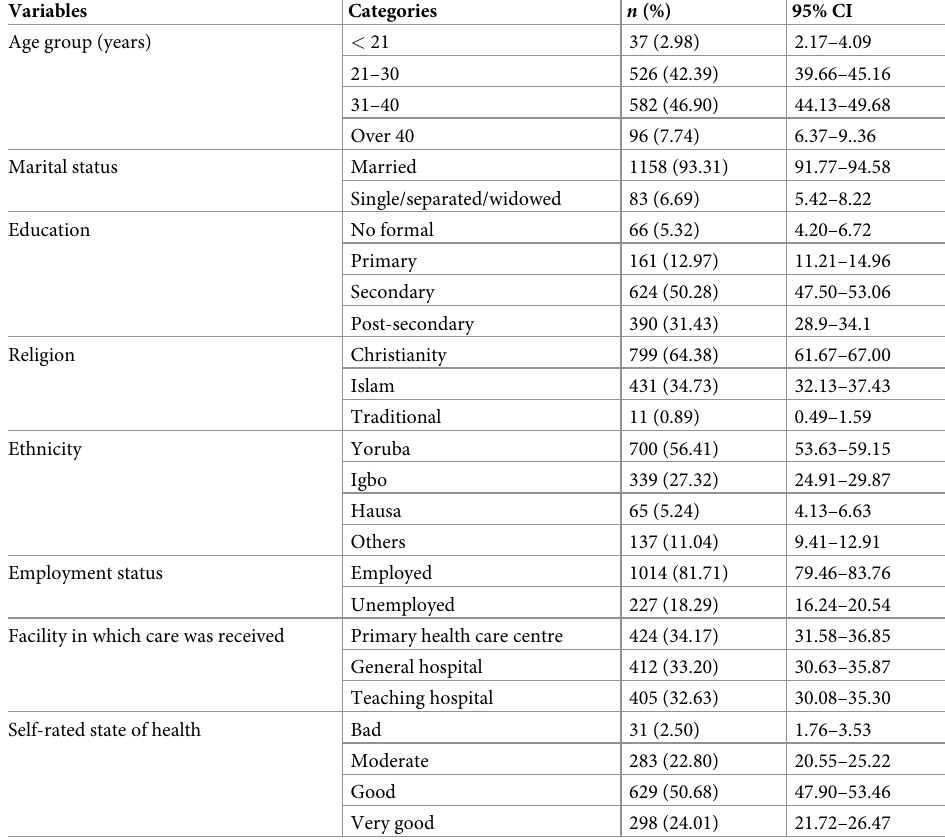
Table 1. Socio-demographic characteristics of clients of RMNCH services during the COVID-19 outbreak in Lagos (N = 1241).